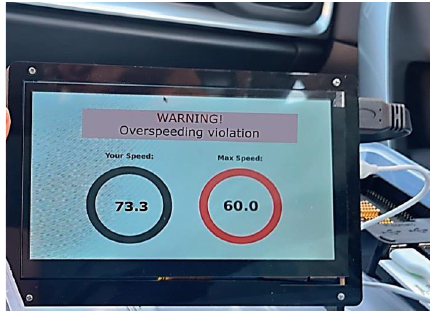
Figure 7: Developed prototype in